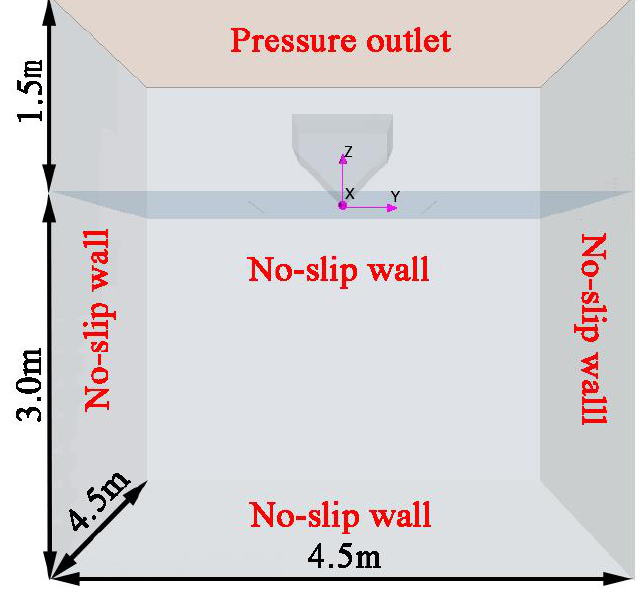
Figure 5. Numerical tank and boundary conditions.